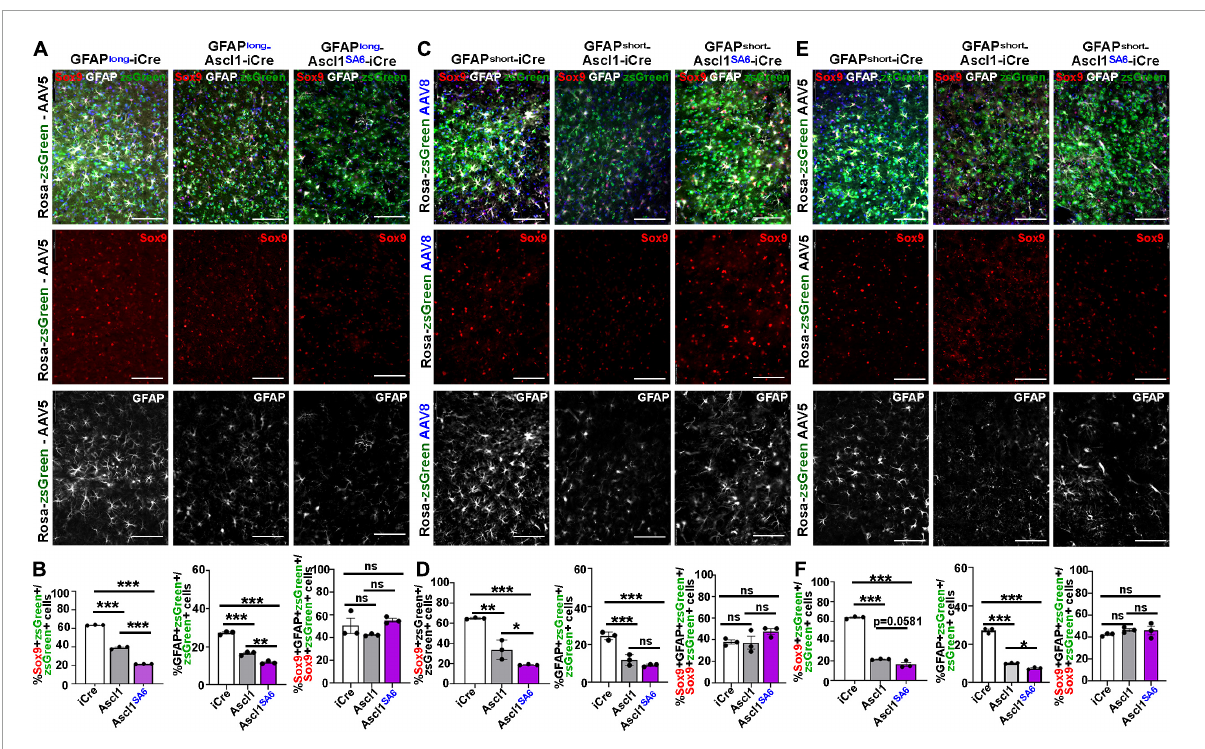
FIGURE5 Ascl1 SA 6 more efficiently represses astrocytic markers Sox9 and GFAP in transduced cortical cells compared to Ascl1. (A) Rosa-zsGreen cortex transduced with AAV5-GFAPlong-iCre, AAV5-GFAPlong-Ascl1-t2a-iCre, and AAV5-GFAPlong-Ascl1 SA 6 -t2a-iCre at 21 days post-transduction, showing zsGreen epifluorescence, Sox9 (red) and GFAP (white) expression in merged and separate channels. Blue is a DAPI counterstain. (B) Quantification of the percentage of zsGreen + cells that co-express Sox9 or GFAP, and the percentage of zsGreen + Sox9 + cells that co-express GFAP. (C) Rosa-zsGreen cortex transduced with AAV5-GFAPshort-iCre, AAV5-GFAPshort-Ascl1-t2a-iCre, and AAV5-GFAPshort-Ascl1 SA 6 -t2a-iCre at 21 days post-transduction, showing zsGreen epifluorescence, Sox9 (red) and GFAP (white) expression in merged and separate channels. Blue is a DAPI counterstain. (D) Quantification of the percentage of zsGreen + cells that co-express Sox9 or GFAP, and the percentage of zsGreen + Sox9 + cells that co-express GFAP. (E) Rosa-zsGreen cortex transduced with AAV8-GFAPshort-iCre, AAV8-GFAPshort-Ascl1-t2a-iCre, and AAV8-GFAPshort-Ascl1 SA 6 -t2a-iCre at 21 days post-transduction, showing zsGreen epifluorescence, Sox9 (red) and GFAP (white) expression in merged and separate channels. Blue is a DAPI counterstain. (F) Quantification of the percentage of zsGreen + cells that co-express Sox9 or GFAP, and the percentage of zsGreen + Sox9 + cells that co-express GFAP. Scale bars = 100 µ m. Significance was defined as p -values less than 0.05 and denoted as follows: ns, not significant, < 0.05 *, < 0.01 **, < 0.001